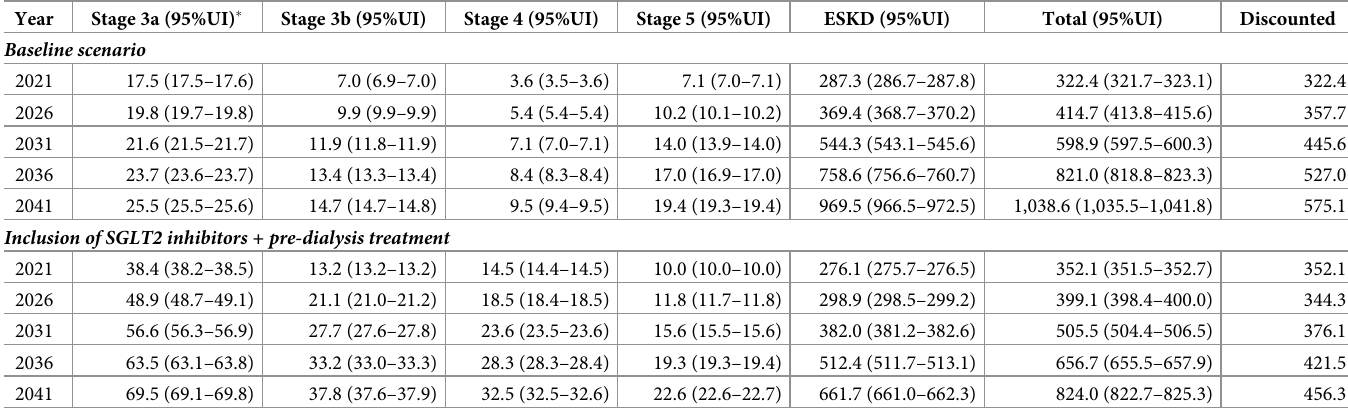
Table 4. Projection of the future costs (in million GBP) of CKD by stage for years 2021–2041.